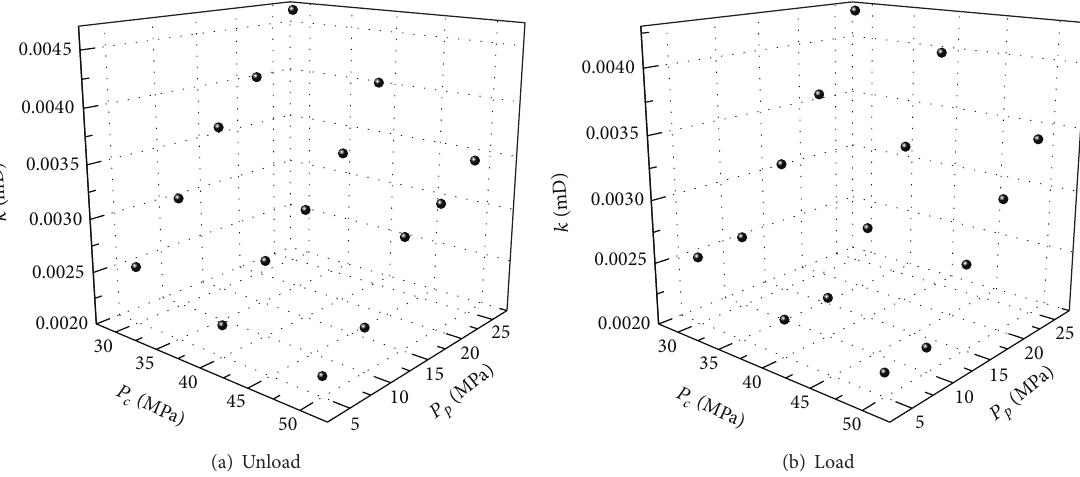
Figure 8: Permeability versus pore pressure and confining pressure measured by distilled water when unloading (a)/loading (b) the pore pressure under three different confining pressure